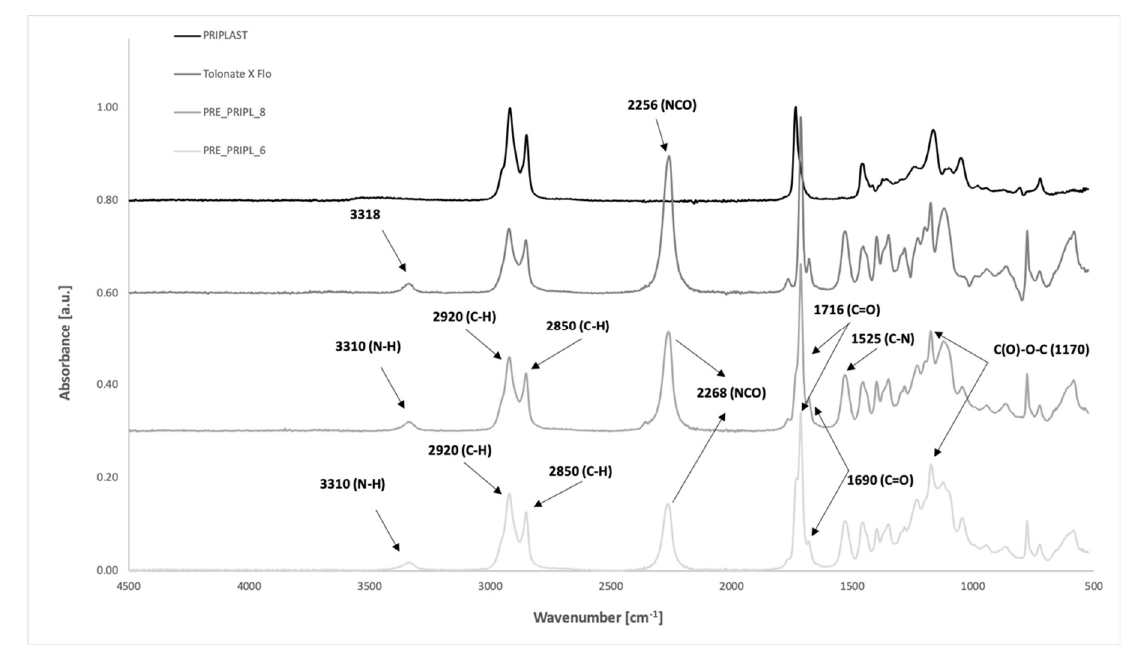
Figure 1. FTIR spectra of ester-urethane prepolymers and monomers.